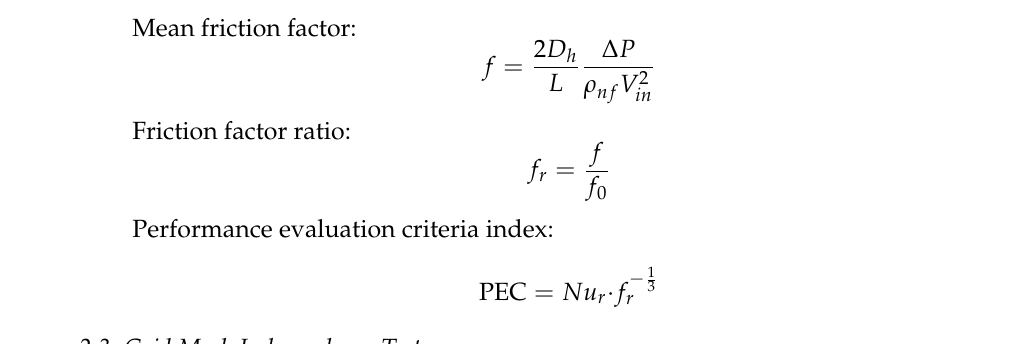
Figure 3. Code validation between numerical data of Yang and Ordonez [42] and obtained numer- ical results from the current study in case of PEC index. Mass flow rate (kg/s)